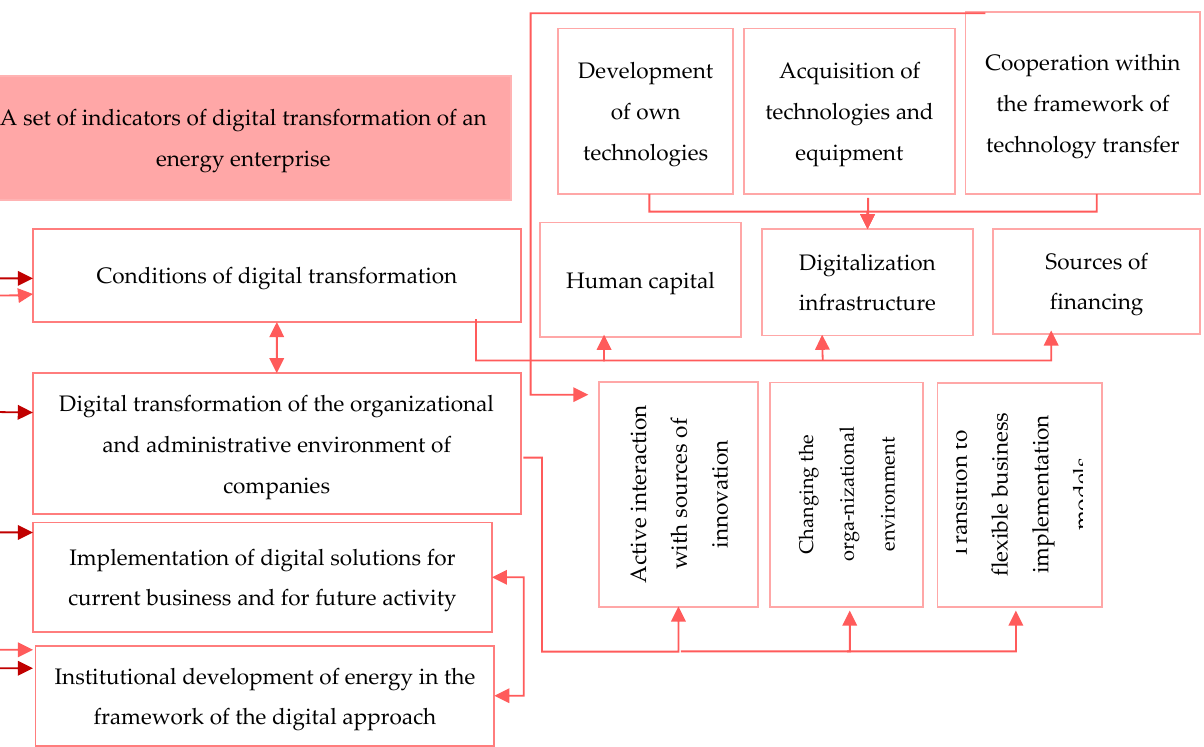
Figure 12. Elements of the energy enterprise activity algorithm based on the principle of “system digitalization” (developed by the authors on the basis of [59]).